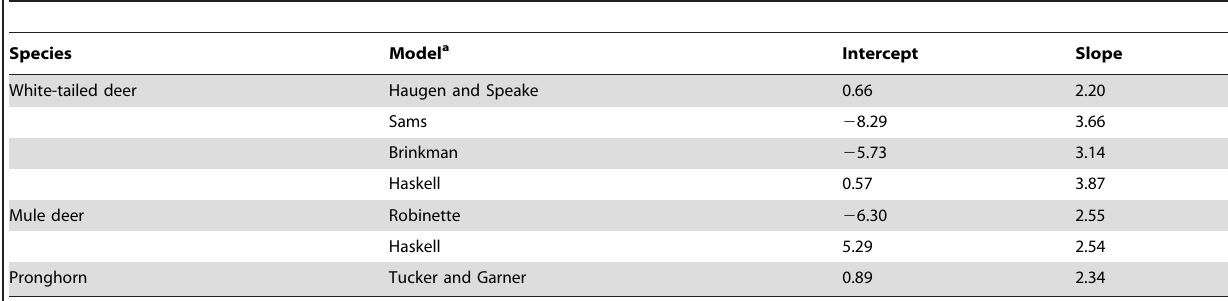
Table 1. Intercept and slope for published neonatal-age models used to estimate age (days) of neonatal white-tailed deer, mule deer, and pronghorn based on measurements of new hoof growth